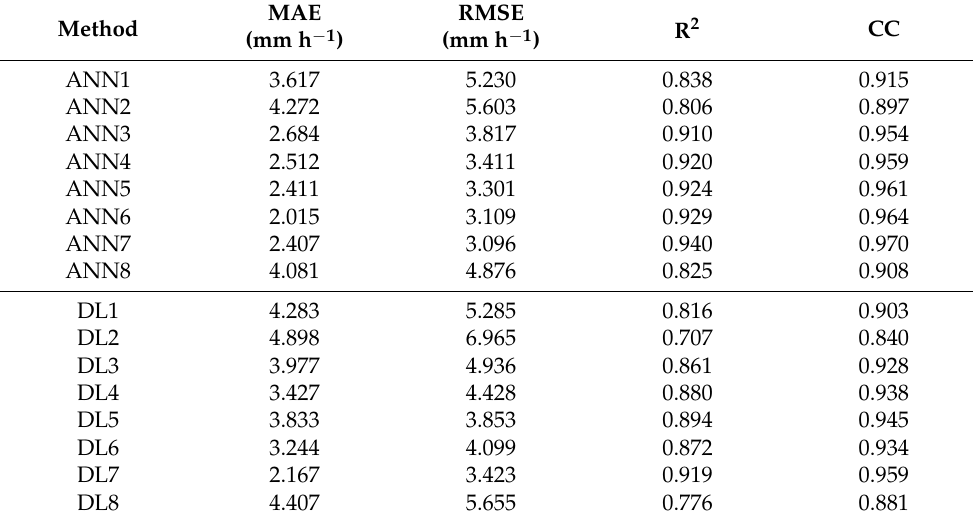
Table 5. Performance metrics of neural-network-based models (ANN and DL) for estimation of Ks with eight different soil data.